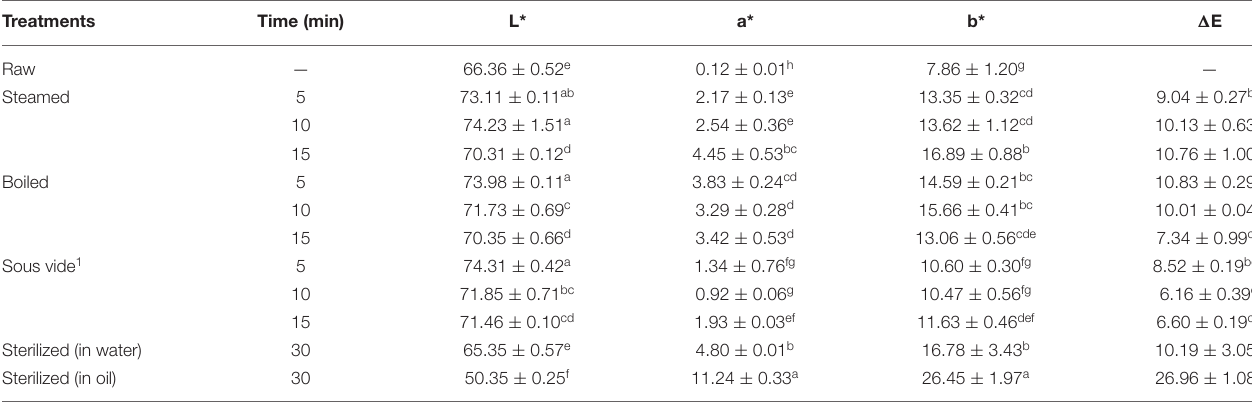
TABLE 2 | Instruments color of raw and processed oyster meat according to the CIE Lab color scale.